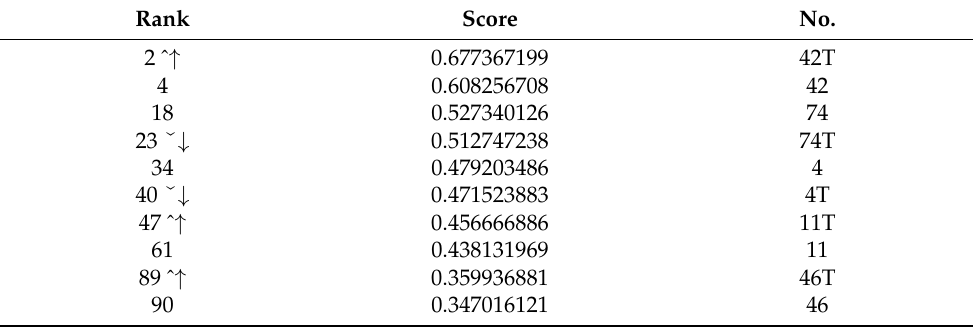
Table 9. Ranking and score of testing